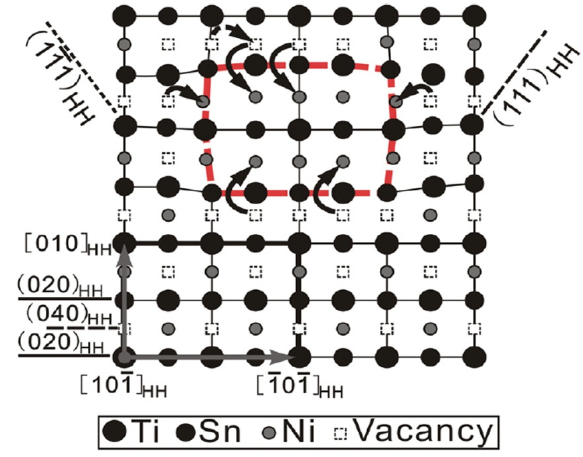
Figure 13. Schematic diagram illustrating the formation of a Ni rich cluster through diffusion of Ni atoms into vacant sites (see arrows). The thick solid line at the bottom left hand side indicates a unit cell with HH structure, and dashed lines indicate [111] lattice HH planes. The diagram is viewed along . Reproduced with permission from HH Reference [120]. Copyright 2012, American Institute of Physics.